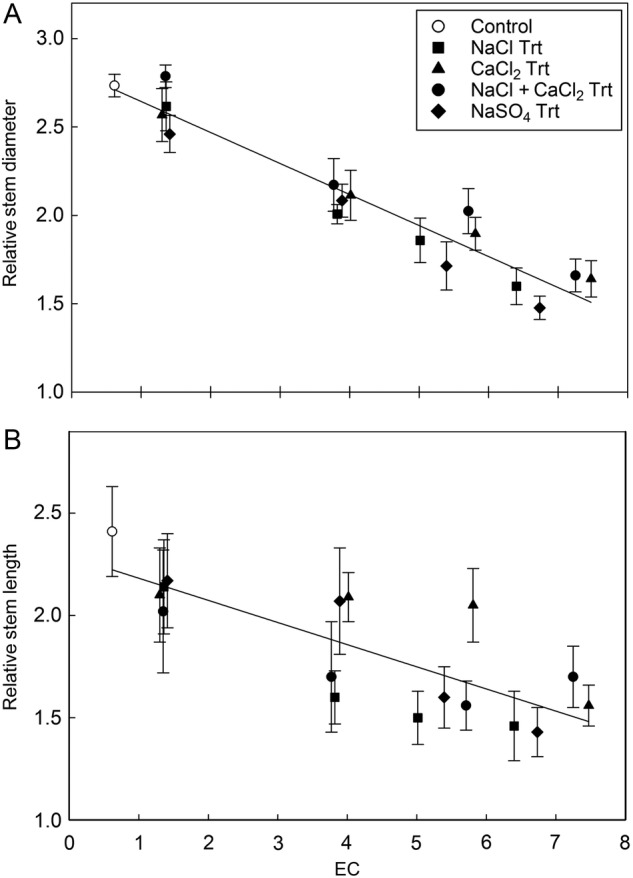
(A) Irrespective of salt ion the relative diameter growth was inversely proportional to the increase in salinity (R2 = 0.75), which was measured as the mean of the irrigation and leachate EC. The R2 relationship between EC and relative diameter growth values for the control and four concentrations within each salinity type ranged from 0.72 for the CaCl2 treatments to 0.82 for the Na2SO4 treatments. Analysis of variance tests indicated that the specific salt (or ion combination) did not have a significantly greater effect on the diameter growth of the stem (P > 0.1). (B) The specific ion (or ion combination) did not have a significantly greater effect on the vertical growth of the stem (P > 0.1). The relative stem growth was poorly explained as a response to increasing salinity (EC) (R2 = 0.27). Yet, there were significant differences in height (P < 0.001) between the different concentration levels within the salt treatment. Pairwise multiple comparisons of the means suggest that the final relative height in the control group and the lowest ion concentration (1.0 dS m−1) were significantly greater (P < 0.05) when compared with the two higher ion concentrations (4.5 and 6.0 dS m−1).